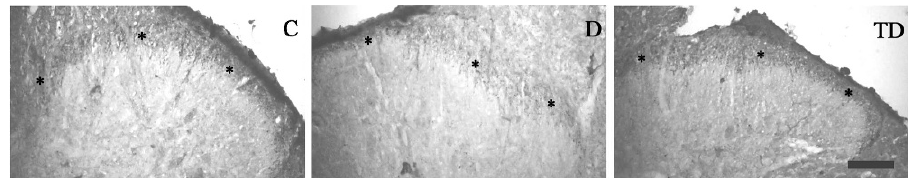
Figure 3 - Digitized images of transverse sections of spinal cord in the C, D and TD animals revealing the CGRP-ir in the dorsal horn of the spinal cord. Note the decreased CGRP-ir in the D group. In the image from the TD animal, note that the CGRP-ir is similar to that of the C animal. The scale bar indicates 100